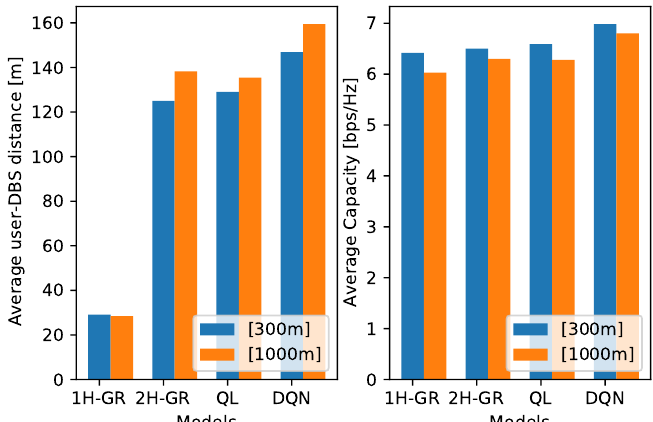
Figure 8. Impact of MBS location on network capacity and user-DBS